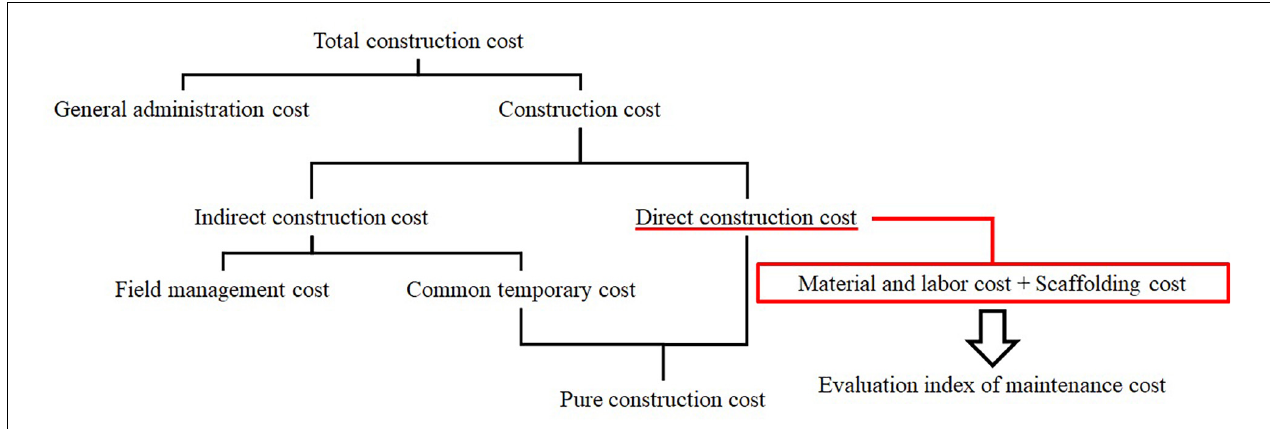
FIGURE 5 | Breakdown of construction